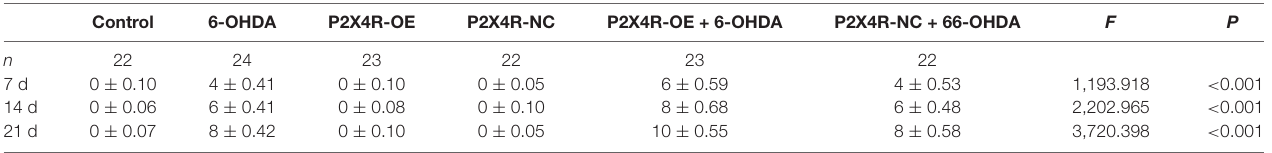
TABLE 1 | Rotation test results of rats in six groups (turns/min).